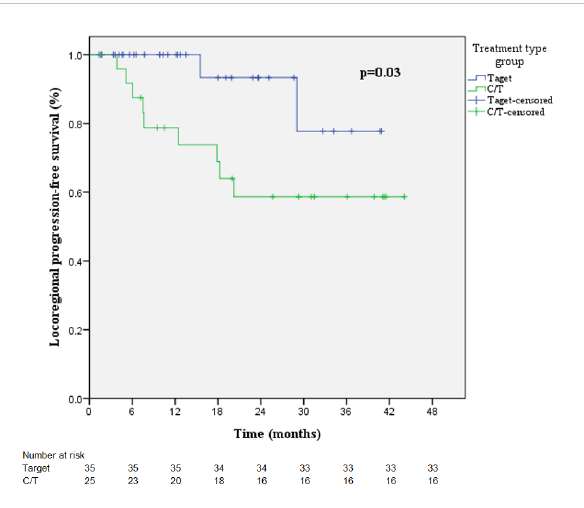
FIGURE 5 Kaplan-Meier curves of LRPFS in the radiotherapy-combined target therapy or chemotherapy treatment